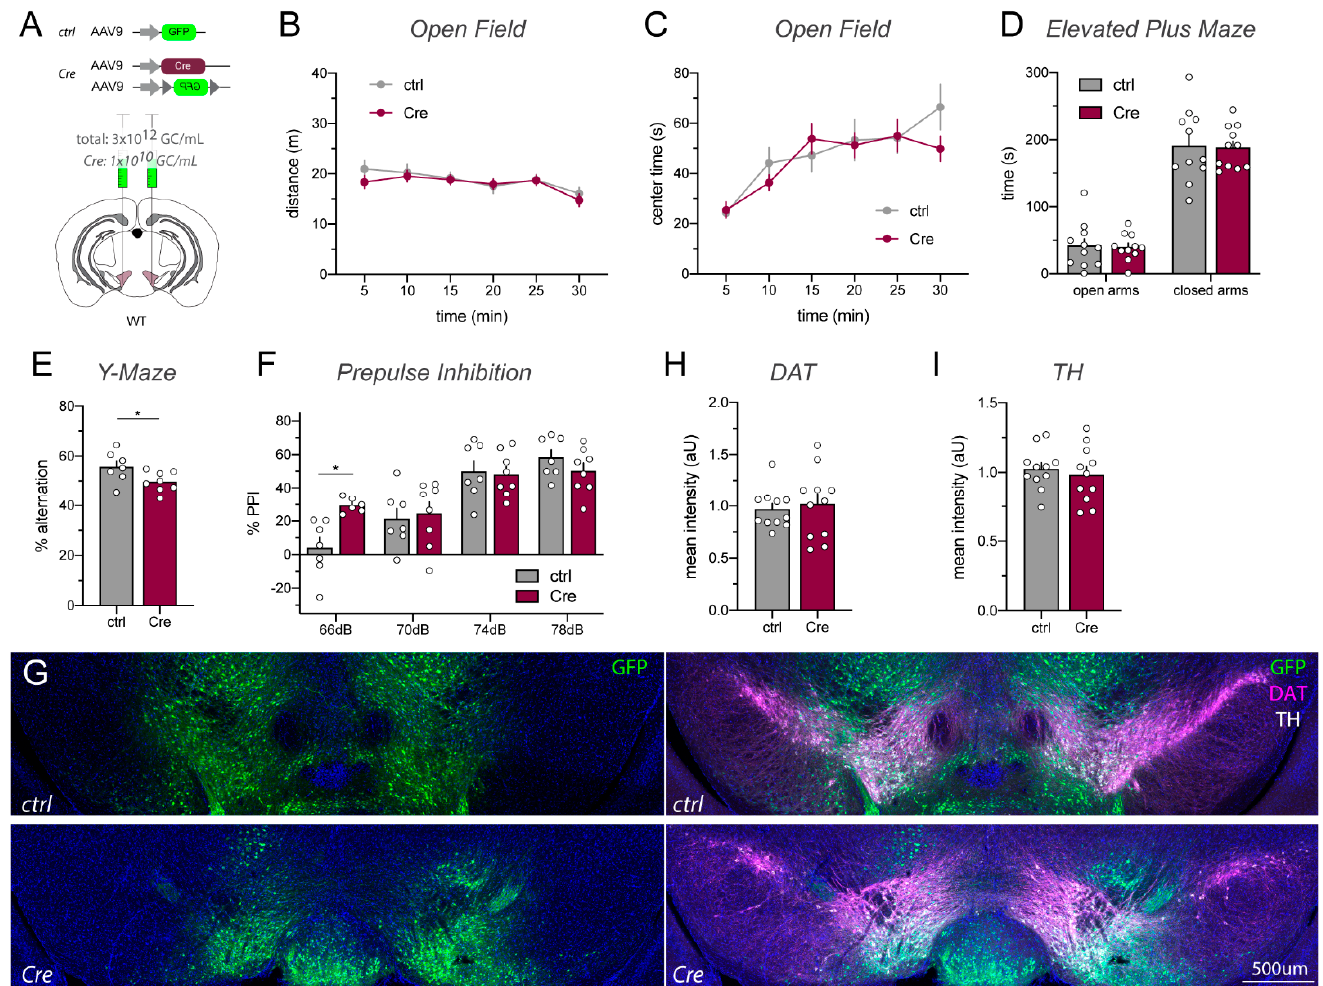
Figure 5. VTA injections of AAV9_Cre at lower titers do not alter behavioral or histological phenotypes. ( A ) Scheme visualizing bilateral injection of AAV9_Cre (10 10 GC/mL) mixed with AAV9_DIO_GFP (2.99 × 10 12 GC/mL; mixture hereafter simply denoted as Cre) and control AAV9_GFP (3.0 × 10 12 GC/mL) into the VTA of adult WT C57BL/6J mice. ( B , C ) Distance traveled and center time spent in the open field task does not differ between Cre- and AAV9_GFP control-injected mice (n = 11/group; ( B ) two-way ANOVA, F(5,100) = 0.7684, p = 0.5747 and genotype: p = 0.5909; ( C ) mixed effects model, F(5,96) = 1.866, p = 0.1074 and genotype: p = 0.4474). ( D ) Anxiety assessed in the elevated plus maze is unaffected in Cre- and control-injected mice (n = 11/group; two-way ANOVA, F(1,20) = 0.00036, p = 0.9851 and genotype: p = 0.6528). ( E ) Spontaneous alternation measured in a Y-maze is slightly decreased in Cre- compared to control-injected mice (ctrl n = 7, Cre n = 8; unpaired t -test, p = 0.0442 *). ( F ) Sensorimotor gating is largely unaffected (ctrl n = 7, Cre n = 8; mixed effects model, F(2.184, 26.93) = 43.11, genotype: p = 0.5549, 66dB p = 0.0243 * (exclu- ( G ) Immunohistochemistry revealed normal histology in Cre-injected mice. ( H , I ) DAT and